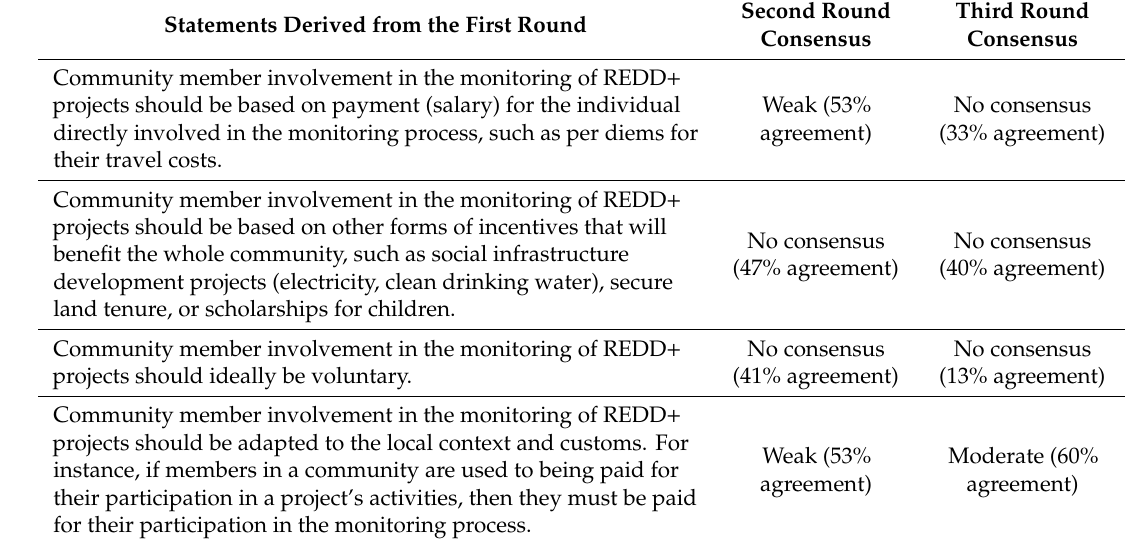
Table 6. Delphi panel results on incentives to engage community members in the monitoring process of REDD + projects in the